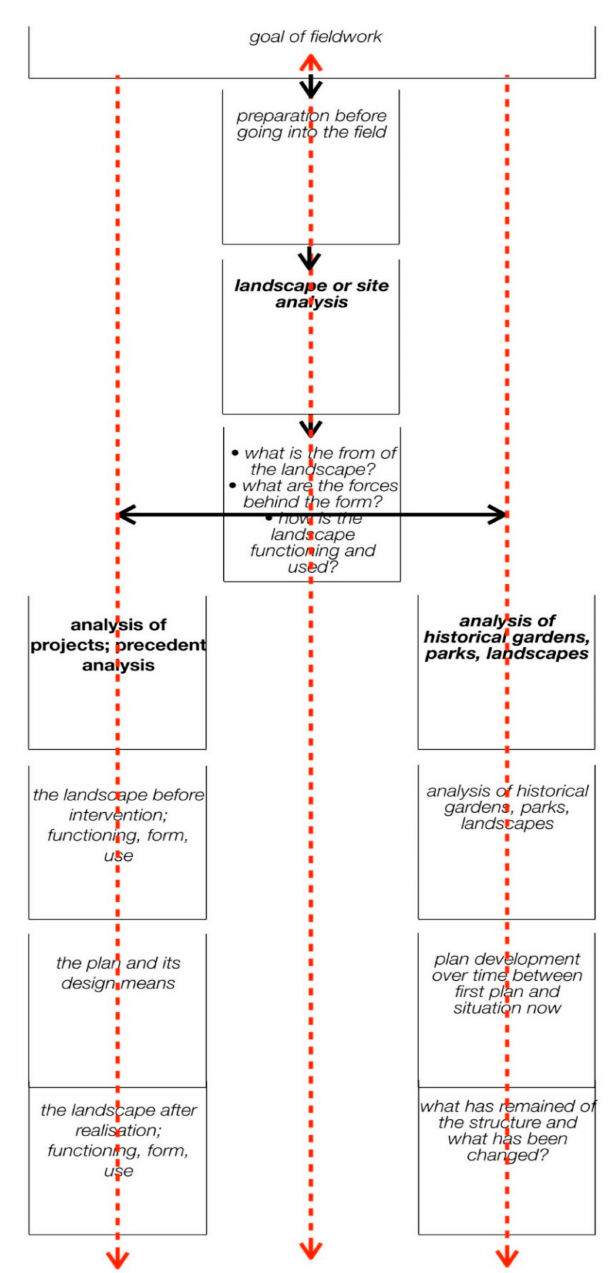
Figure 13. Diagrammatic overview of three different goals for fieldwork and their content referring either to precedent analysis or analysis of historical gardens and